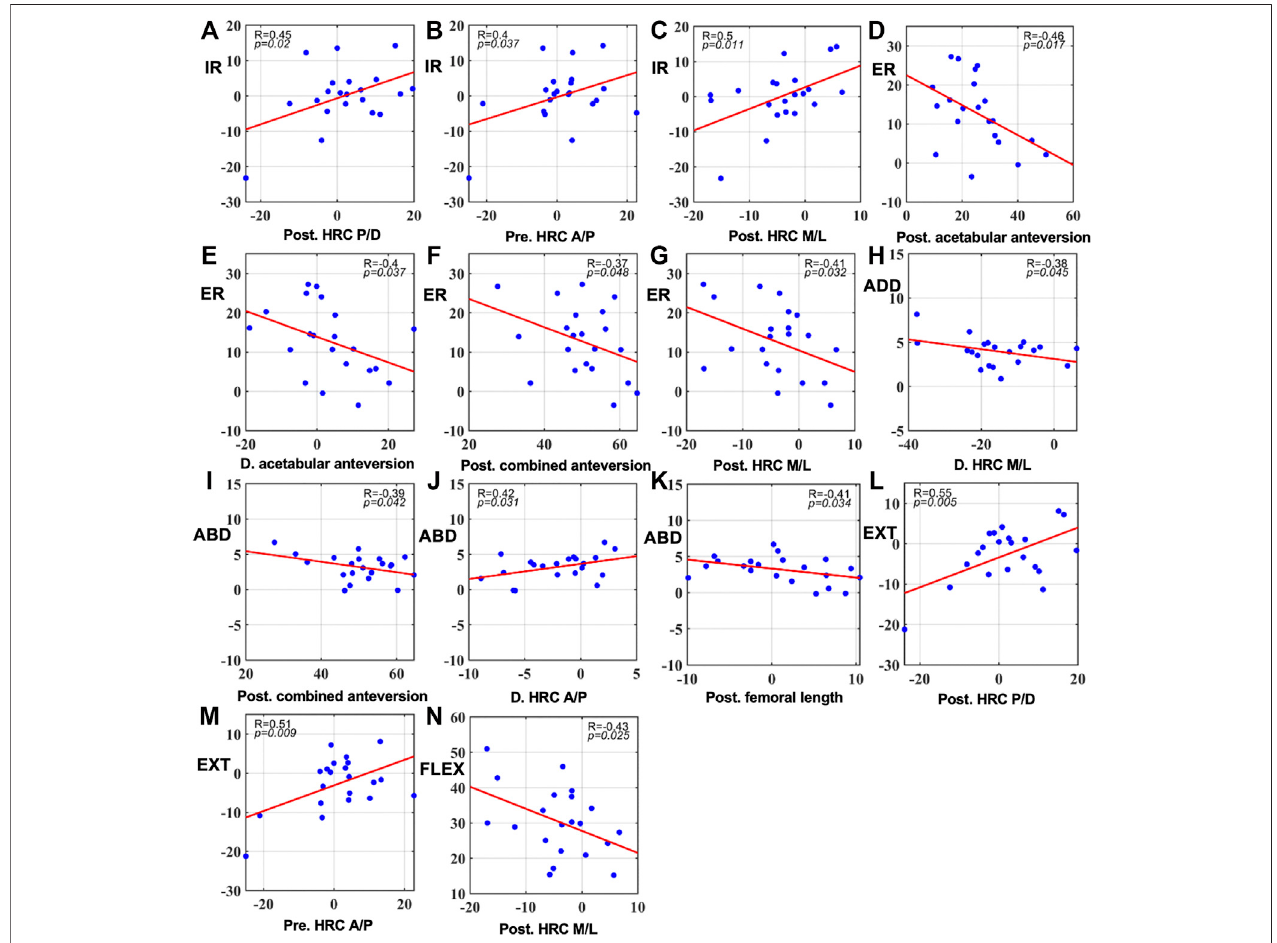
FIGURE3| Signi fi cantcorrelationsbetweengait6-DOFROMandpreoperativeandpostoperativecomponentpositionsaswellastheirchangesinsurgery( (A – C) : correlations with internal rotation. (D – G) : correlations with external rotation. (H) : correlation with adduction. (I – K) : correlations with abduction. (L,M) : correlations with extension. (N) :correlationwith fl exion. p < 0.05).Pre: preoperative; Post:postoperative. D: Difference calculatedbypostoperative dataminus preoperativedata.Angles were measured in degrees ( ° ) and distance in millimeters (mm).